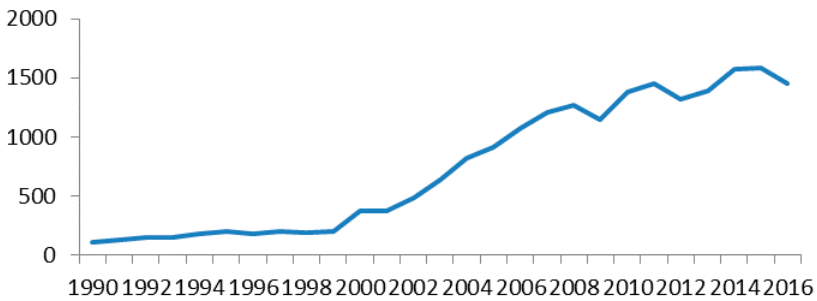
Figure 3. UK textile imports value from China (unit: dollars in millions). Source: UN ComTrade SITC Rev. 3, 2017.